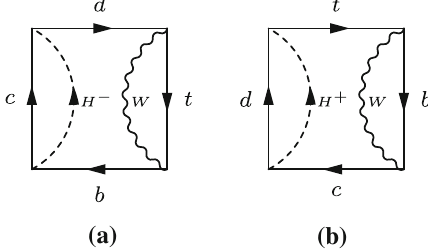
Fig. 4 Attaching A to the fermion lines of these diagrams and the ones with reversed fermion flow generates the first category of relevant diagrams